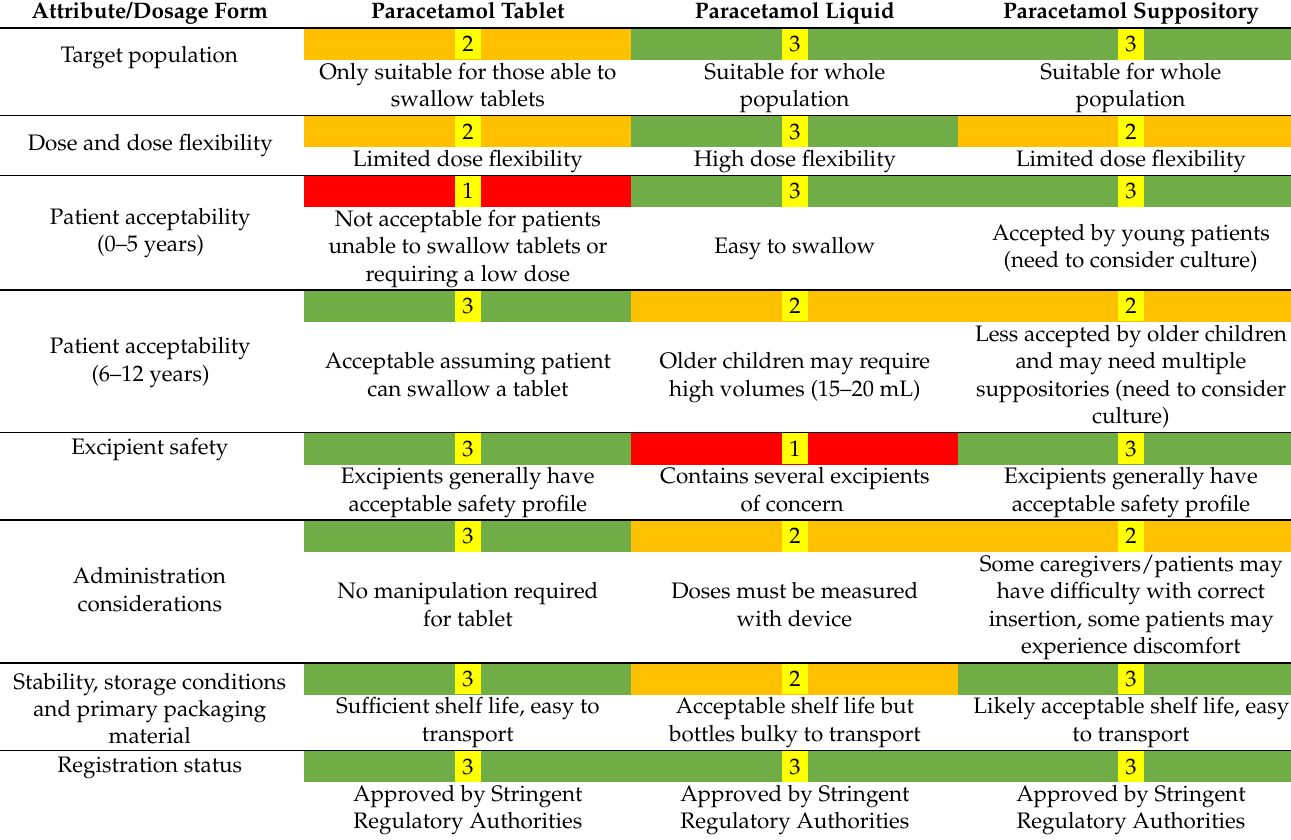
Table 3. pQTPP summary for paracetamol formulations listed in the WHO Essential Medicines List for